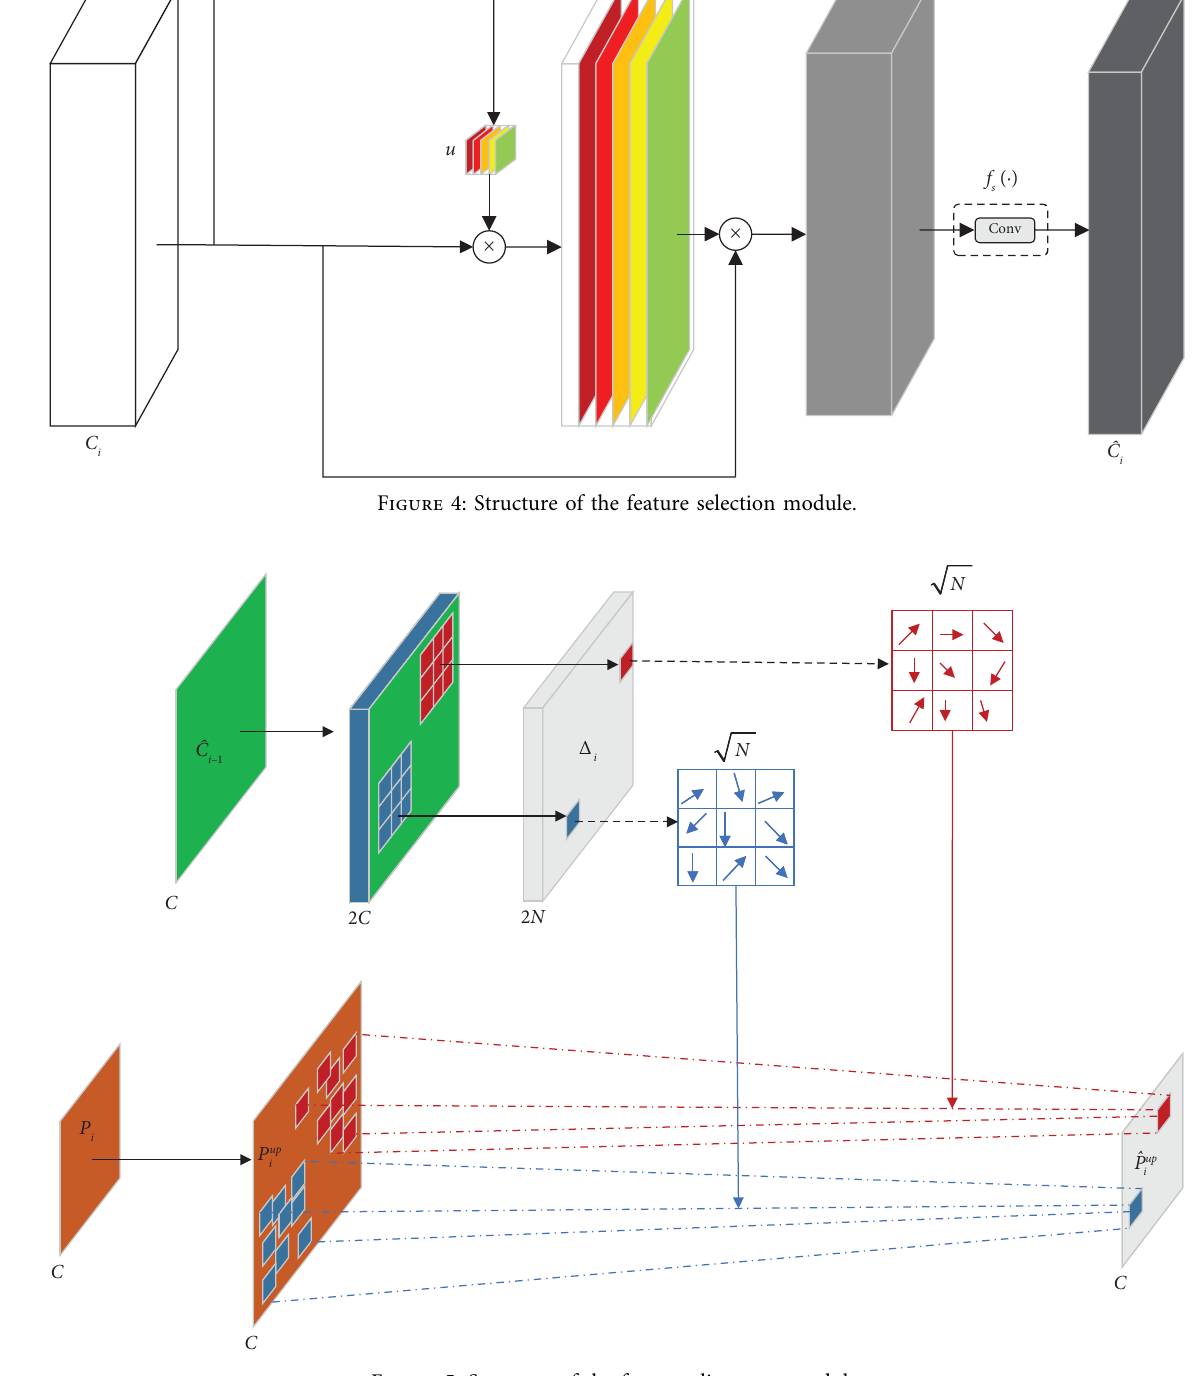
Figure 5: Structure of the feature alignment